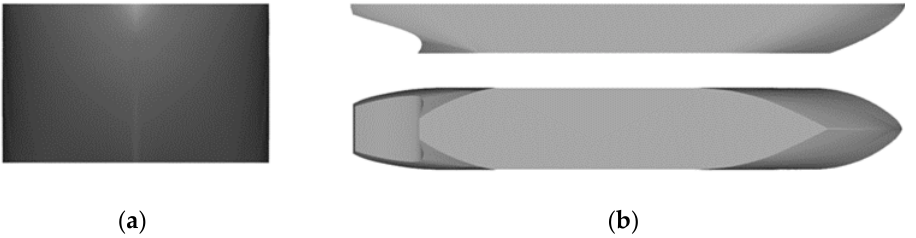
Table 3. Ship parameters of traditional icebreaker bow.